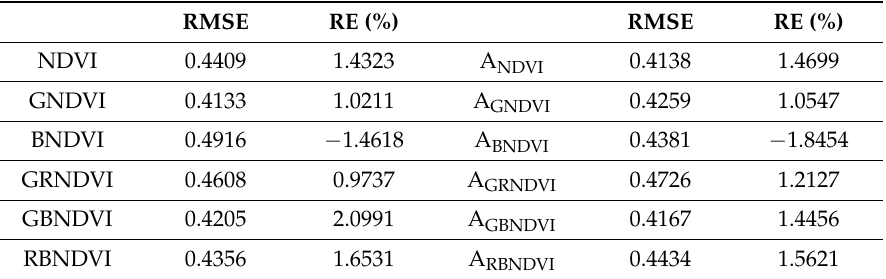
Table 3. The verification results of NDVI and its derivative parameters.